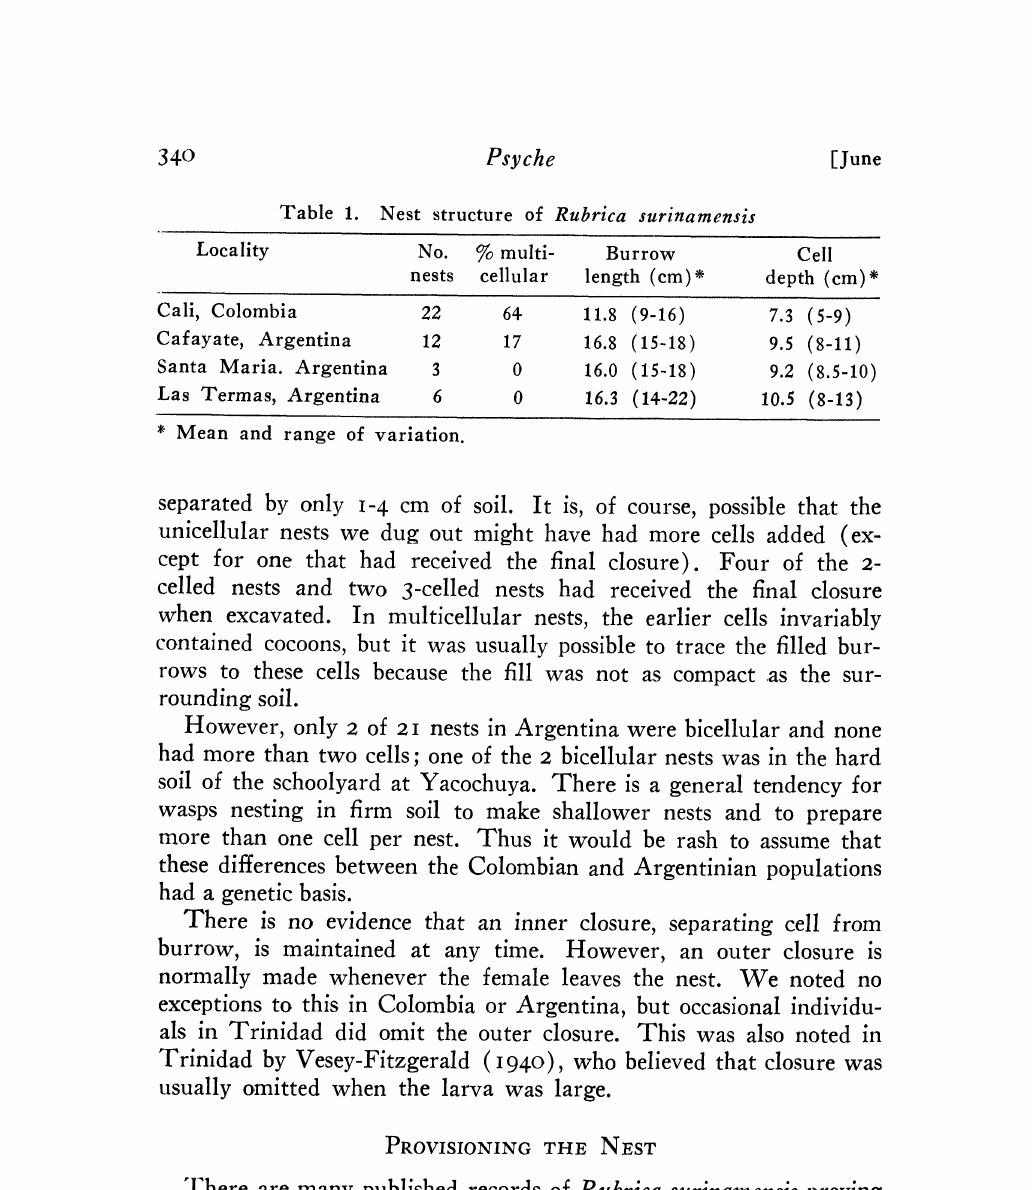
Table 1. Nest structure of Rubrica surinamensis Locality No. % multi- Burrow Cell nests cellular length (cm)* depth (cm)* Cali,